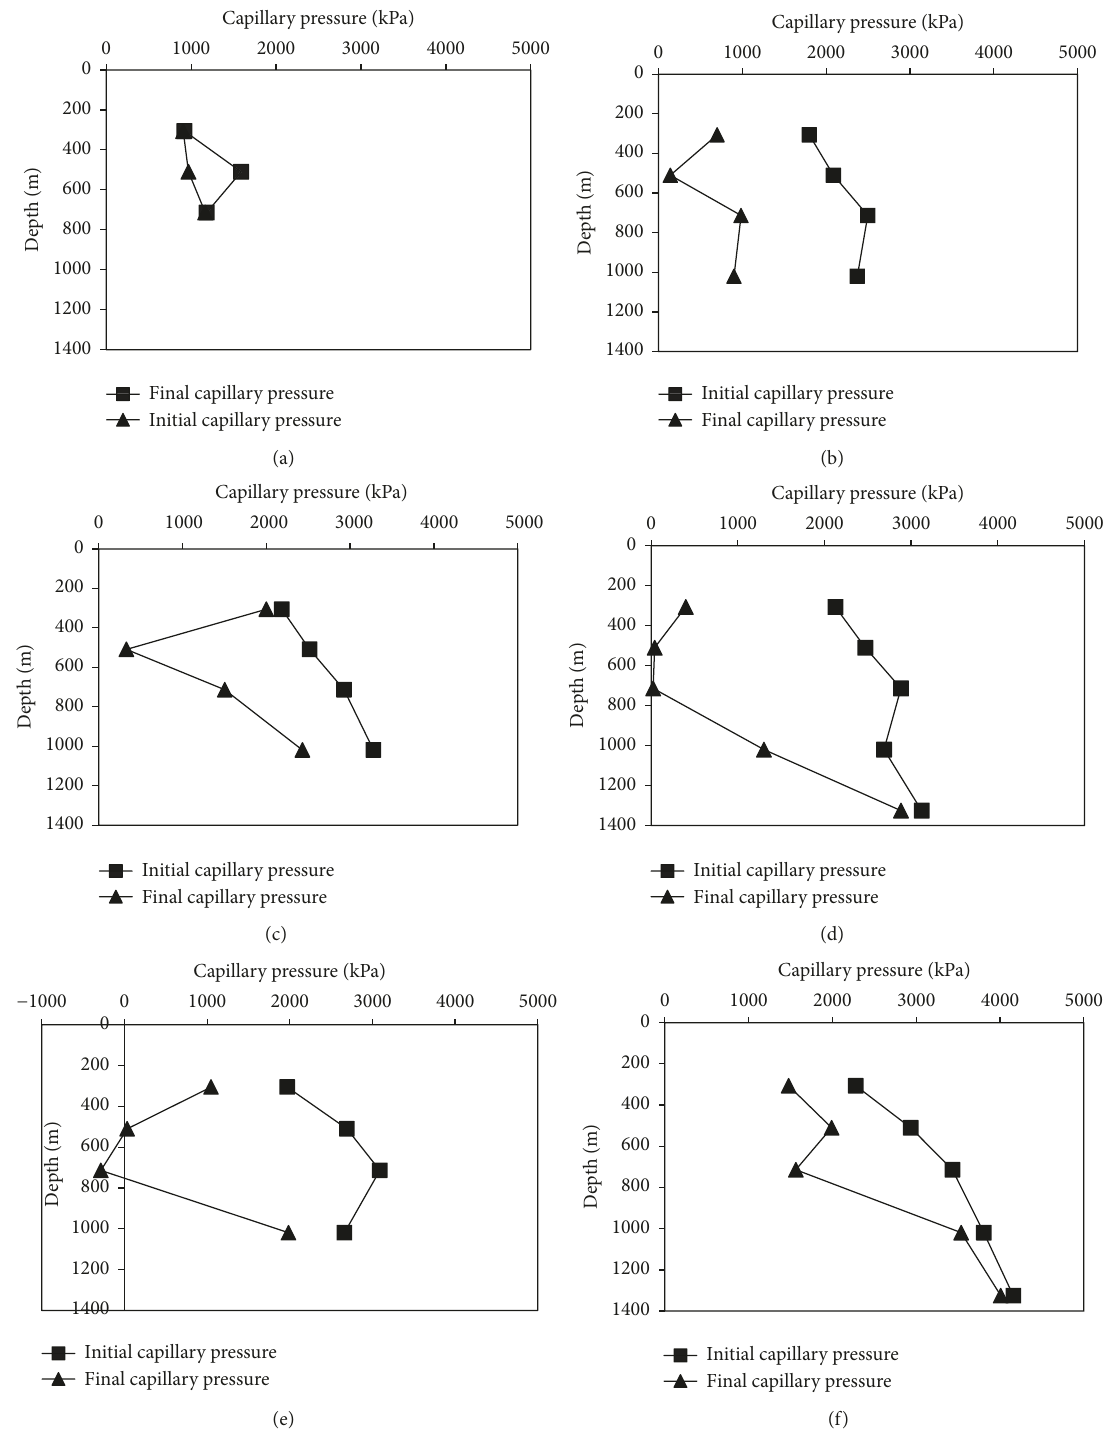
Figure 9: Capillary pressure with depth. (a) Type V5 with deionized water, (b) type V1 with deionized water, (c) type V5 with 1MNaCl, (d) type V1 with 1 MNaCl, (e) type V5 with 3 MNaCl, and (f) type V1 with